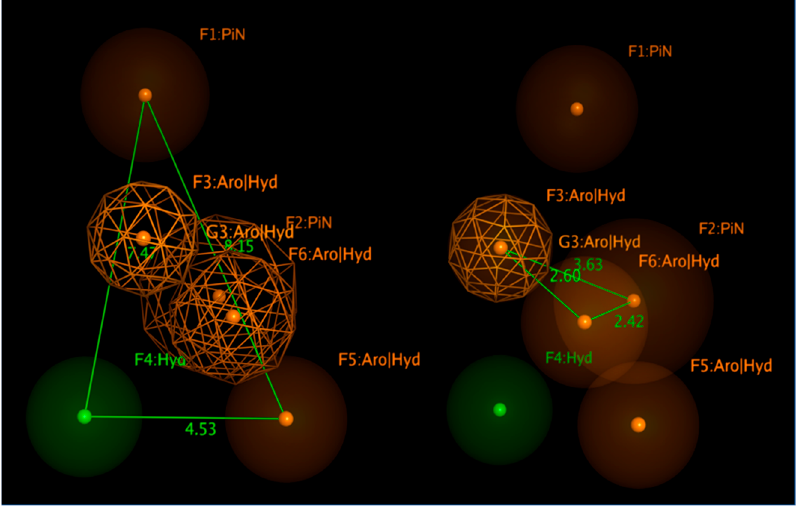
Figure 18. Most relevant pharmacophore features shared by the collected RSV F protein inhibitors and related distances.